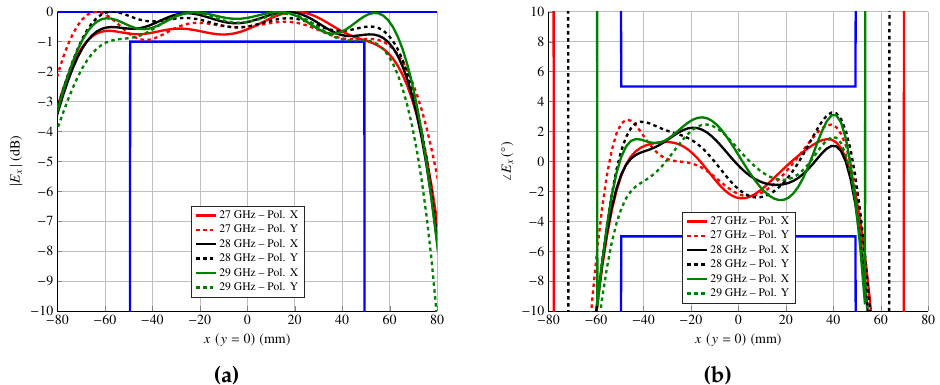
Figure 7. Main cut y = 0mm of the near field after the wideband multi-frequency optimization of the layout for the ( a ) magnitude and ( b ) phase.